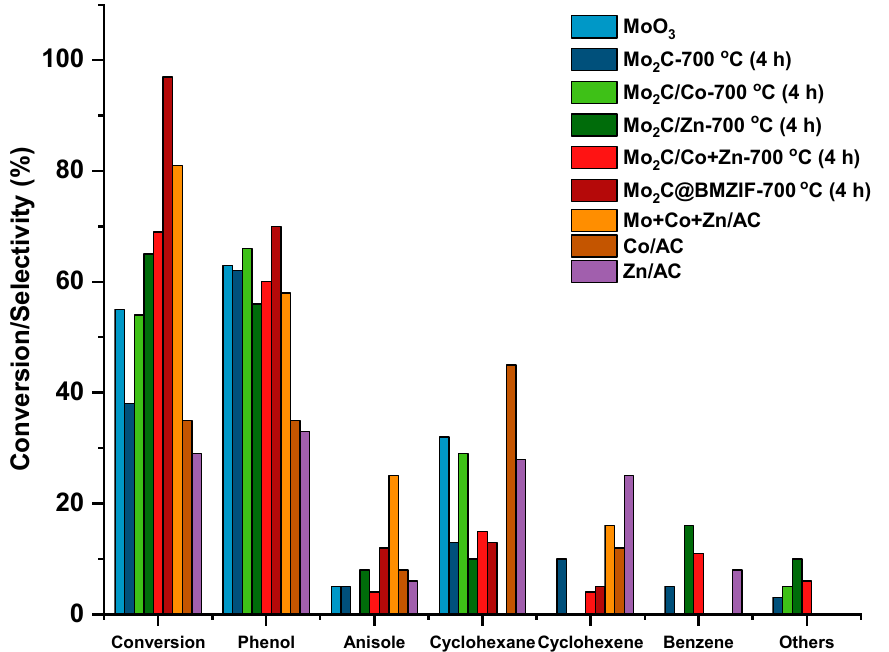
Figure 6. Comparison of conversion and product selectivity of catalytic HDO of guaiacol over various catalysts (reaction condition: catalyst 60 mg, guaiacol 0.12 g, n -decane 20 mL, 330 °C, 4 h, 4 MPa).